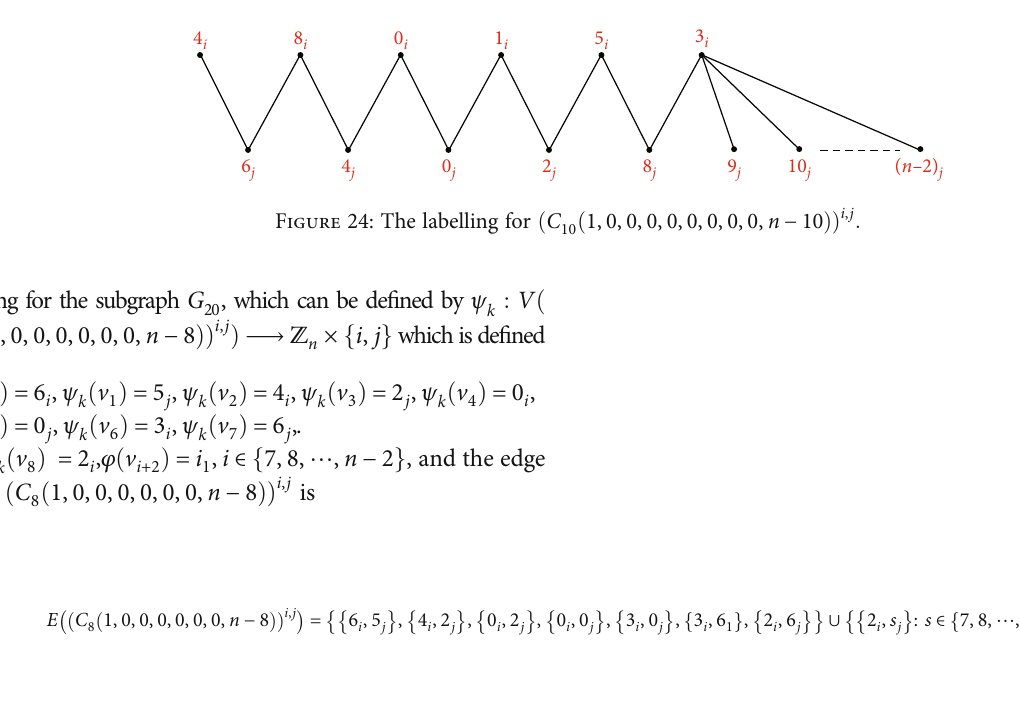
1, 0, 0, 0, 0, 0, 0, 0, n − 9 ÞÞ i , j : 9 ð